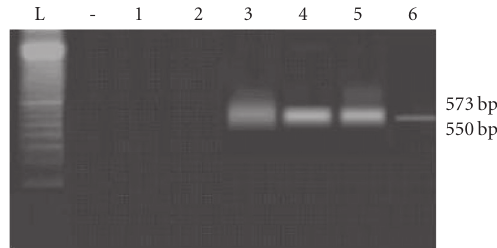
Figure 5. RT-PCR amplification of the enterotoxin C gene tran- scripts on the 5 S aureus isolates that tested positive for the corre- sponding gene by PCR. Lane L: 100-bp ladder; lane (-): negative control; lanes 1–5: RT-PCR amplicons of S aureus isolates from psoriatic patients; lane 6: 550-000-bp positive